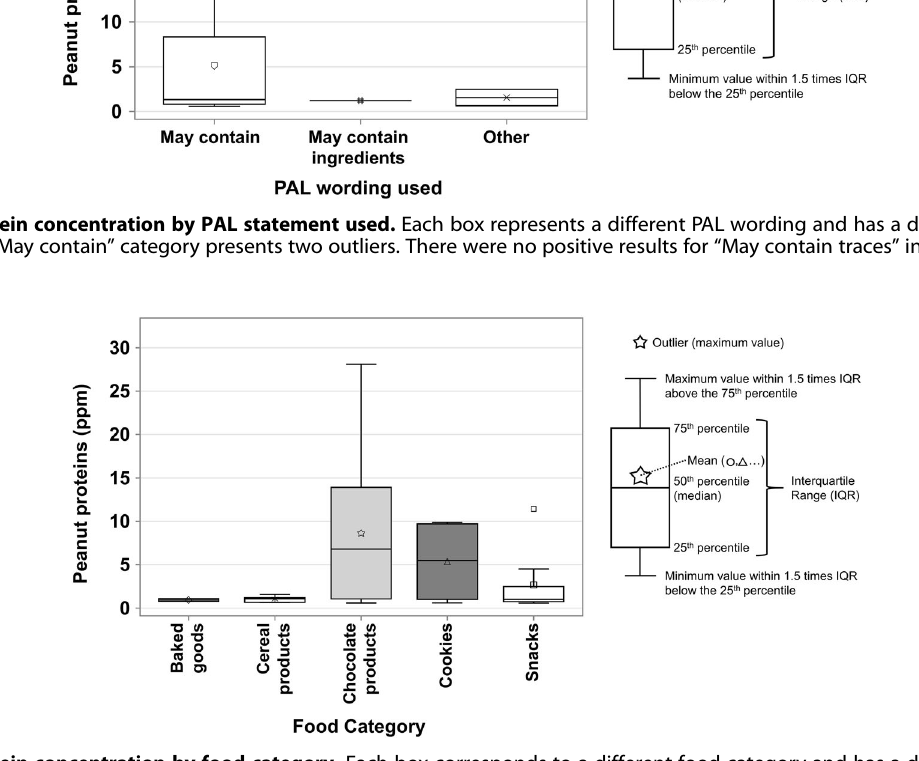
Fig. 2 Peanut protein concentration by food category. Each box corresponds to a different food category and has a different color-symbol combination. The “ Snacks ” category presents one outlier. The other food categories (Baking mixes, Candies, Savoury biscuits) had no positive results for